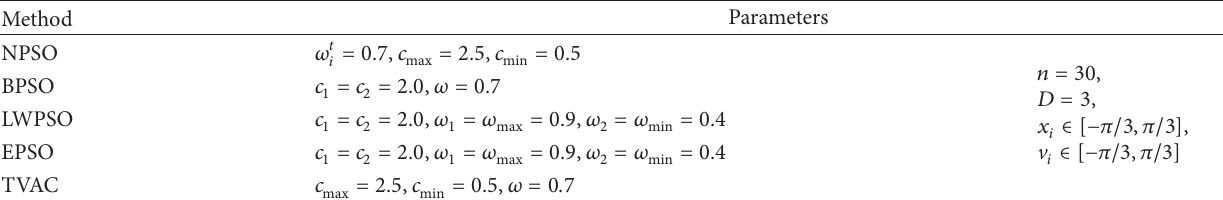
Figure 6: Path planning in dynamic obstacles environment. Table 3: Parameters for simulation.